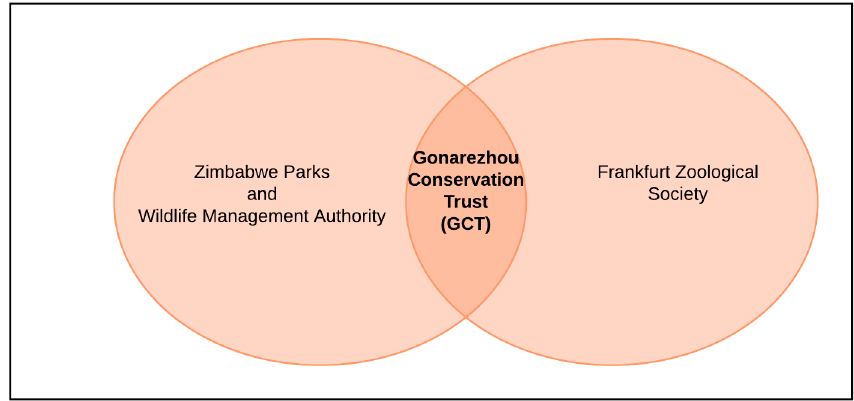
Figure 2. Gonarezhou Conservation Trust setup.